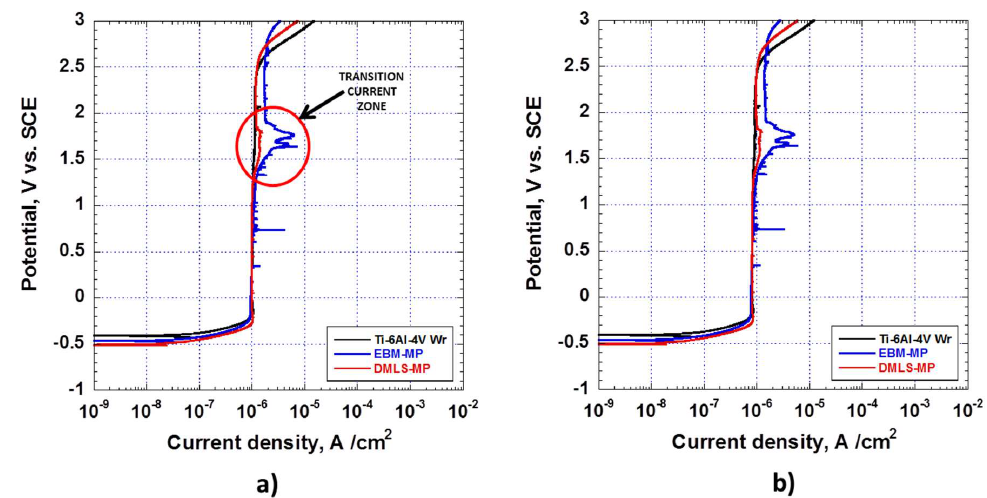
Figure 10. ( a ) Potentiodynamic polarisation curves obtained by considering the geometrical area of the EBM-MP (blue curve) and DMLS-MP (red curve) specimens, compared to the Ti-6Al-4V Wr specimen (black curve); ( b ) Potentiodynamic polarisation curves obtained by considering the estimated surface area by means of topographical measurements.